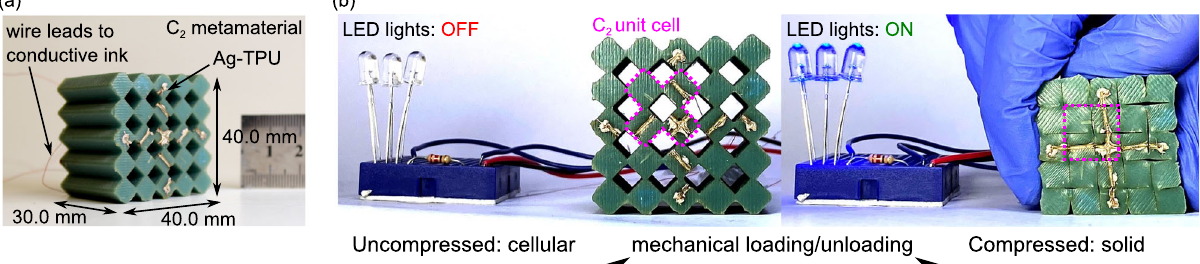
Fig. 1 Compaction principle of electrical network switching in soft, conductive mechanical metamaterials. a Introduction of a metamaterial composed of C 2 unit cell with conductive Ag-TPU trace. b C 2 metamaterial in series with a power source and LED array to illustrate switching functionality. Uncompressed: Open circuit, LED off. Compacted: Closed circuit, LED